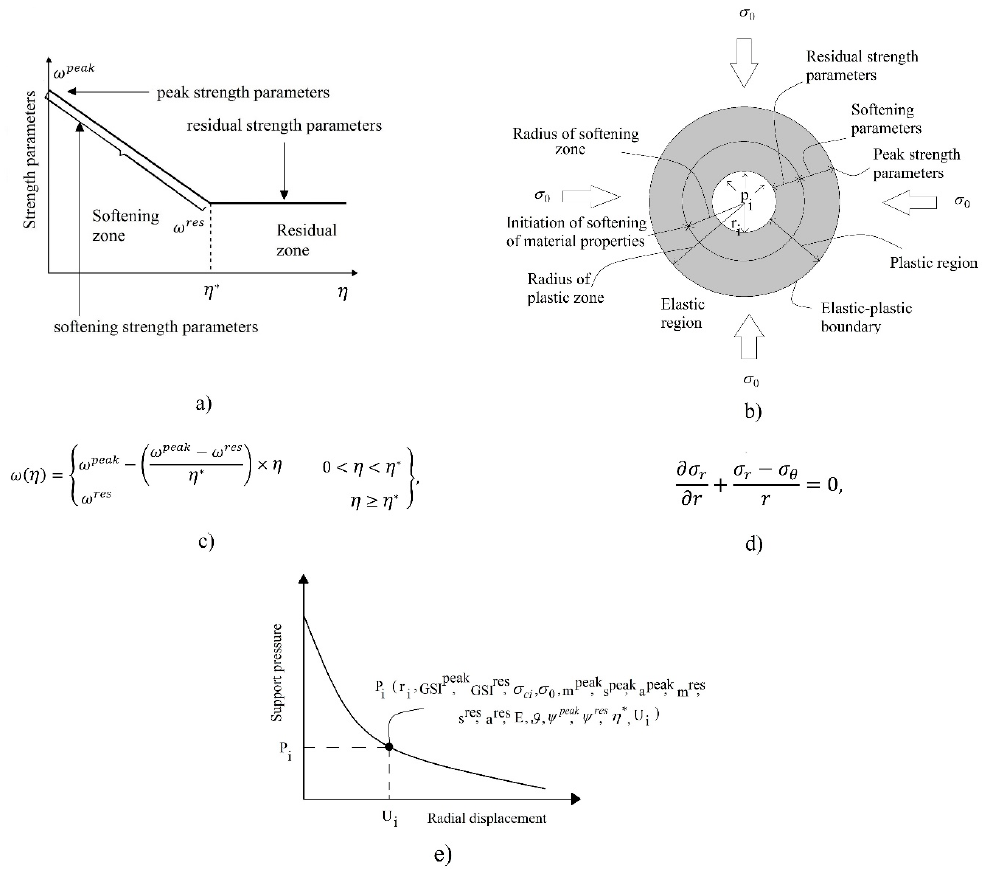
Figure 1. Description of: ( a ) different zones and corresponding strength parameters; ( b ) a circular tunnel in an elastic-plastic, strain-softening rock mass; ( c ) corresponding relationships for strength parameters; ( d ) governing equilibrium equation; ( e ) schematic view of a typical ground reaction curve (GRC) and parameters (Hoek–Brown case) affecting on the curve. In Figure 1, (cid:2026) (cid:3045) is the radial stress, and (cid:2026) (cid:3087) represents the tangential (hoop) stress, while the distance from the center of tunnel is shown using the (cid:1870) parameter. Thus, compatibility equations are simultaneously used to solve the stress–strain around the tunnel. In this regard, a plastic potential function and associated/non-associated flow rules are applied to find the governing relationship between the radial and tangential plastic strains [1,4,5,7–10,11–13]. The stress–strain around the tunnel is also calculated, considering the strength parameters in different zones (the peak, residual, and softening parameters), as presented in Figure 1a,c, according to reference [4]. As explained in reference [4], using different yield and potential functions, the non-associated flow rule is the modeled and adopted as the flow rule in all the cases. Also, starting from the peak strength parameters, the deterioration of the strength parameters of the material (referred to as the softening behavior of the rock mass around the tunnel) begins and continues. For softening parameter values higher than the critical value, the residual parameters are taken into the considerations. As shown in Figure 1a,c, (cid:2033)((cid:2015)) represents each of the strength parameters of the rock mass, and (cid:2015) and (cid:2015) ∗ , respectively, are the softening and the critical softening parameters. In this figure, (cid:2026) (cid:2868) is the far-field in situ rock stress. In addition, Mohr–Coulomb and Hoek–Brown strength criteria are commonly used as two appropriate criteria to correctly evaluate the post-elastic behavior of rock mass. These criteria are, also, broadly applied in the literature for the development of the GRC. Hence, in this paper, available solutions with regard to the described problem are gathered, and rigorous datasets